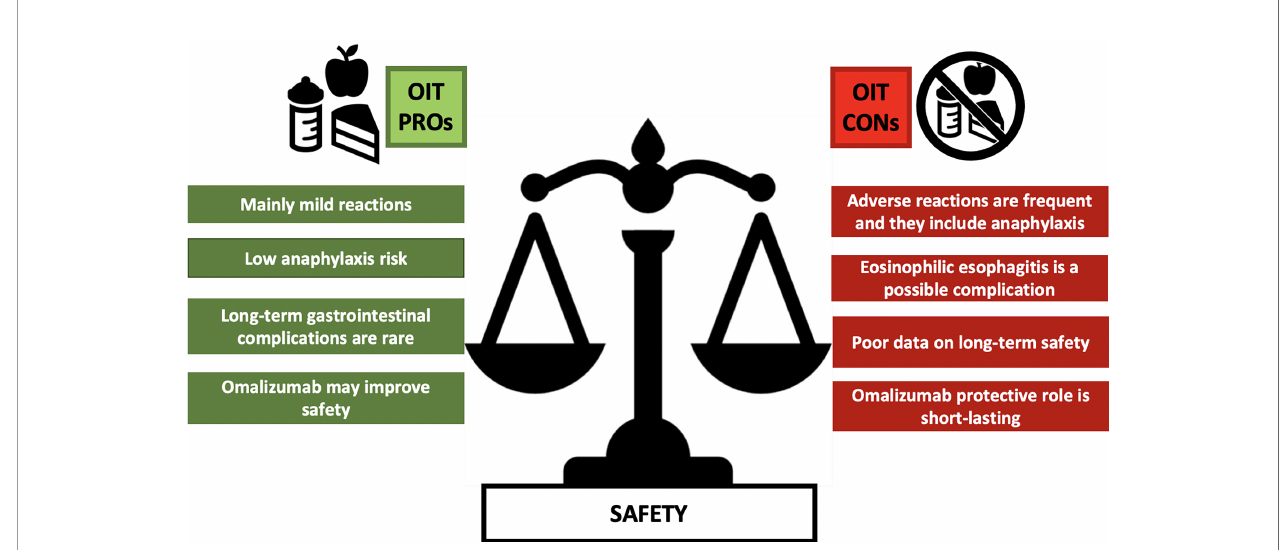
FIGURE 2 | A comparison between the main PROs and CONs arguments on OIT Safety. ARs, adverse reactions; EoE, eosinophilic esophagitis; GI,